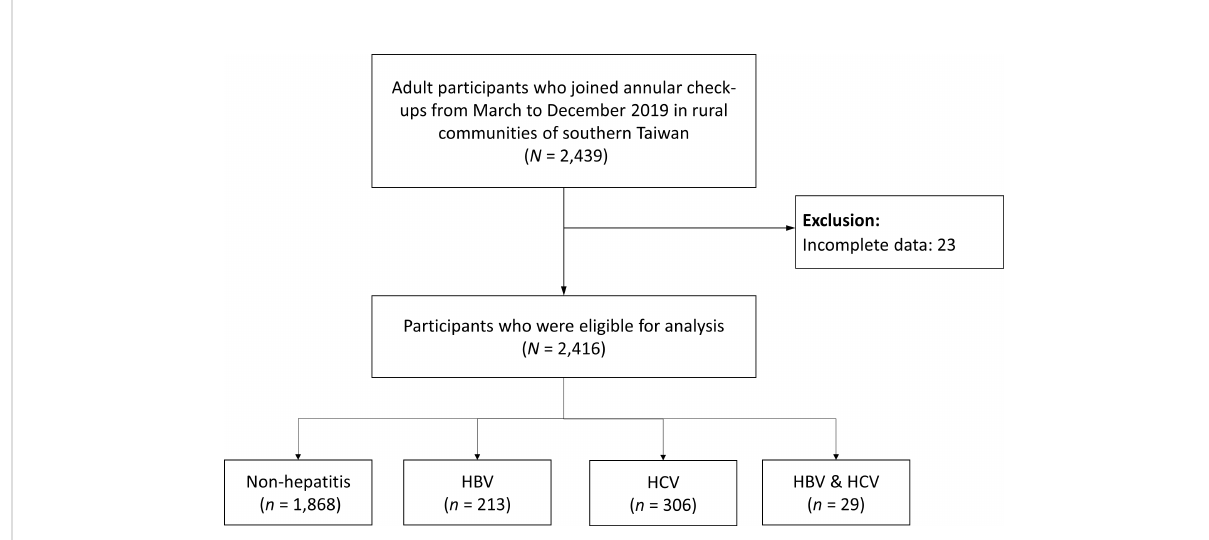
FIGURE 1 Enrollment of the study participants. HBV, hepatitis B virus; HCV, hepatitis C